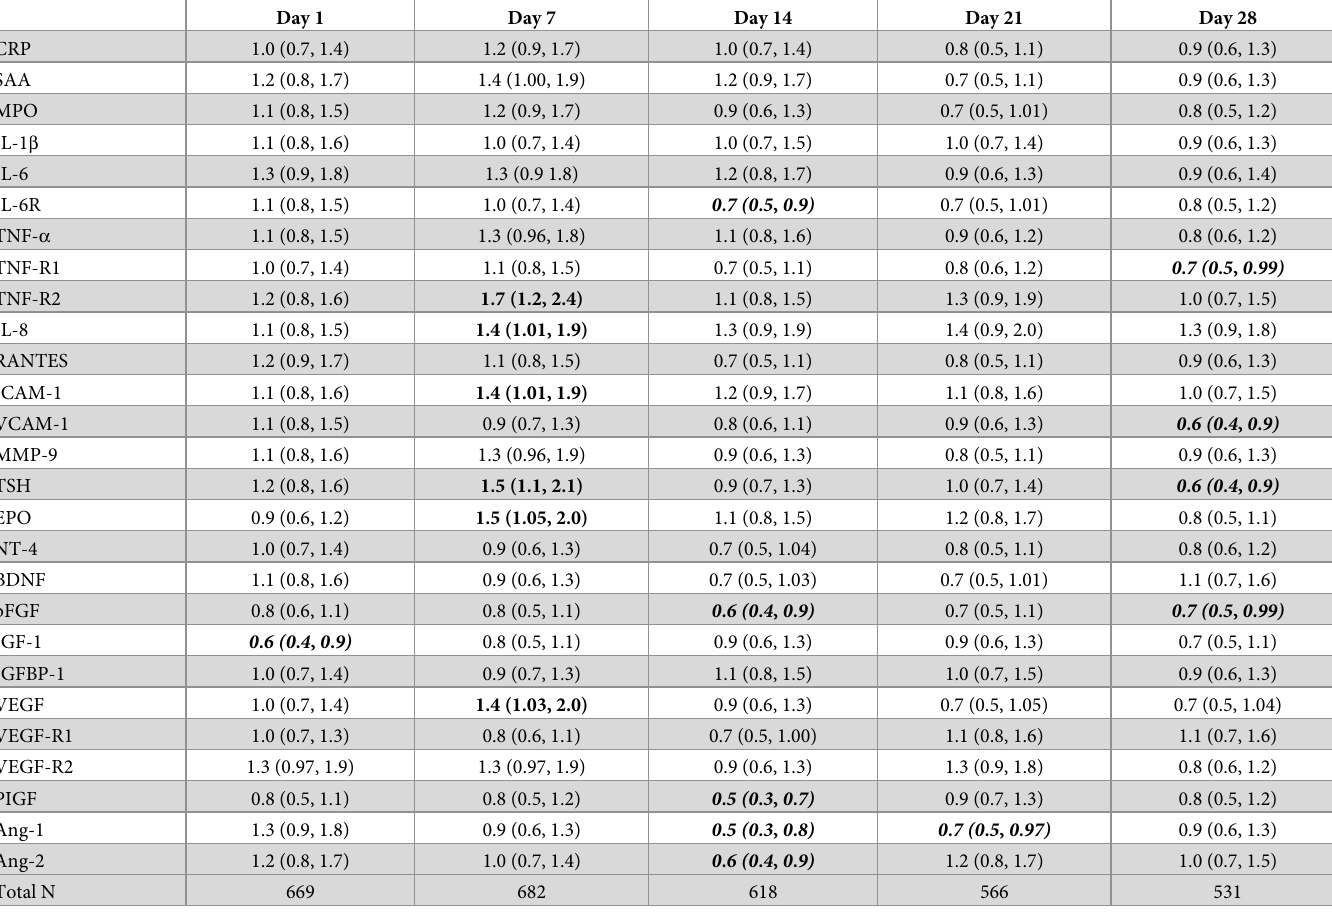
Table 1. Odds ratios and 95% confidence intervals of a top quartile concentration of the protein listed on the left associated with mother’s eligibility for govern- ment-provided medical care insurance. The only adjustments made were for gestational age category and birth weight Z-score < -1. Bold indicates odds ratios significantly > 1.0 (p < 0.05) and bold italic indicates odds ratios significantly < 1.0 (p <